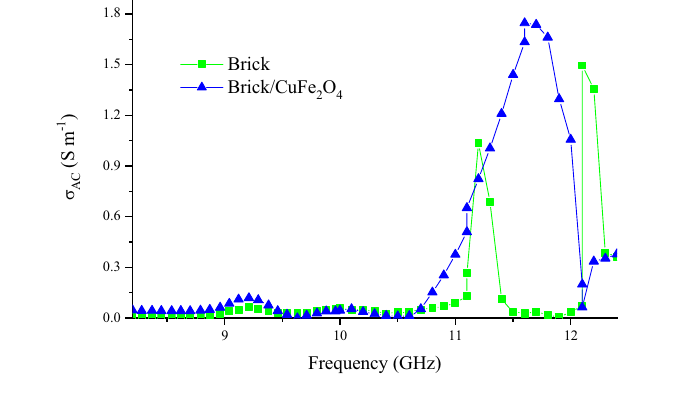
Figure 12. σ AC for the architected samples.